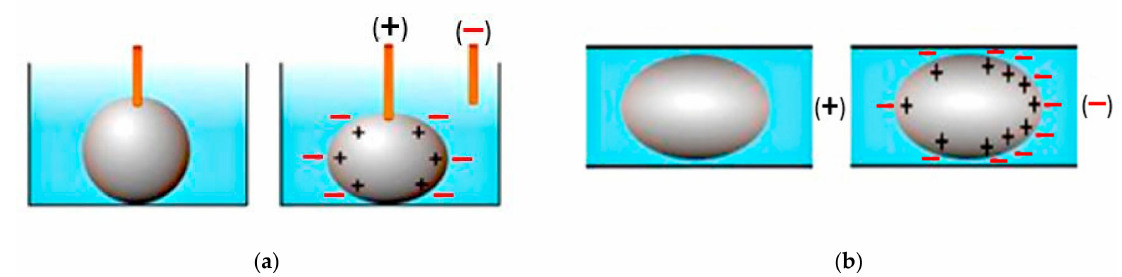
Figure 1. Illustrative comparison between ( a ) electrocapillary actuation (ECA) and ( b ) continuous electrowetting (CEW) [20].